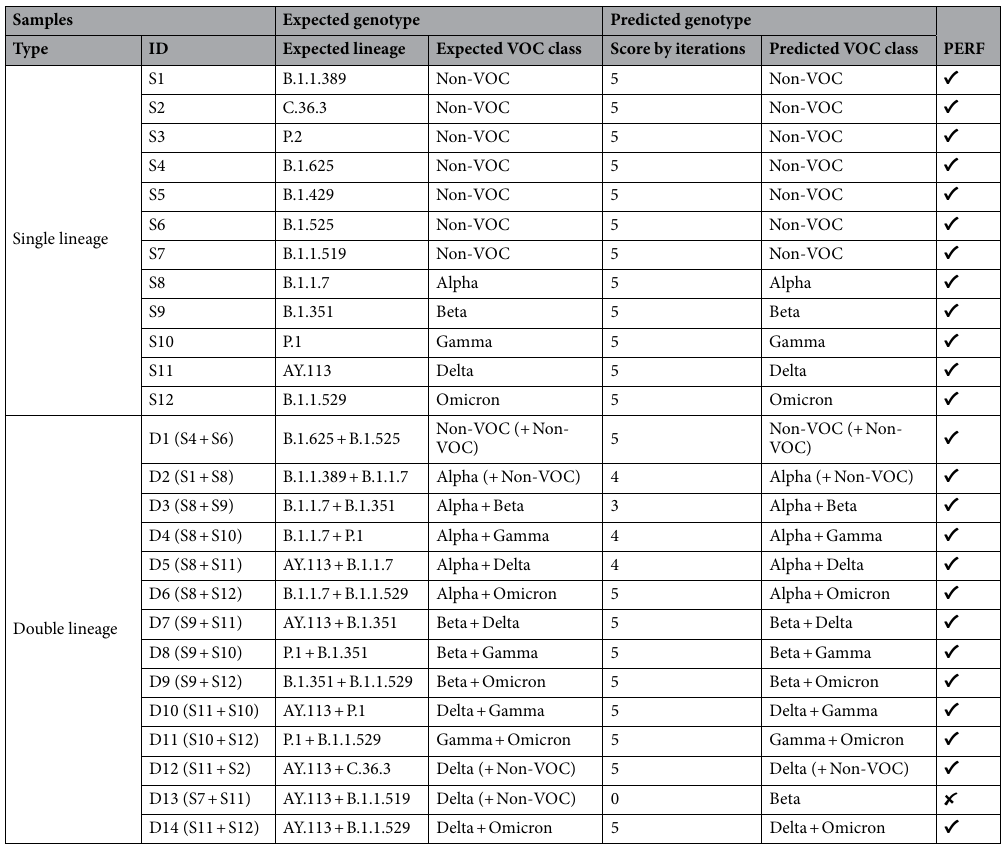
Table 3. Genome classification using an ASV inference strategy with sequencing data for one or two variants of the SARS-CoV-2 virus (PERF: performance of the VOC prediction regarding the expected VOC